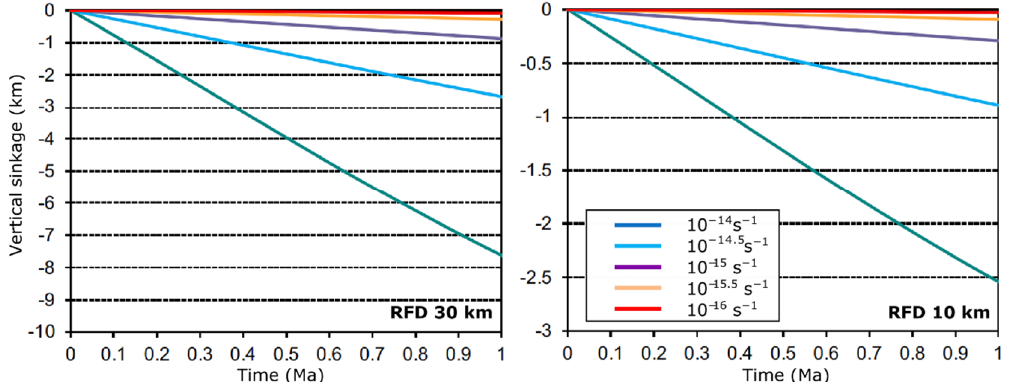
Figure 8. Sinkage versus time curves computed from the best-fit results of the analytical model of transtension using the equations by [73] conveniently modified for transtension. RFD: Rigid Floor Depth, for 30 ( left ) and 10 ( right ) km.